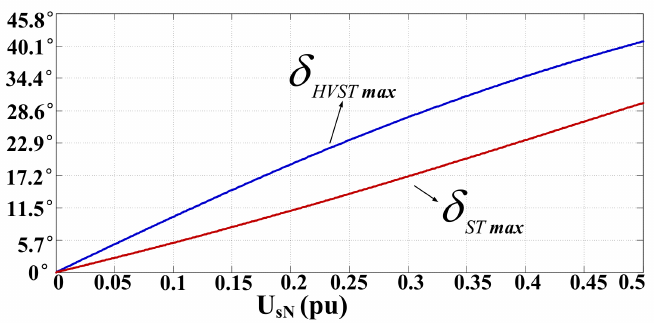
Figure 8. The phase-shift angles of the ST and the